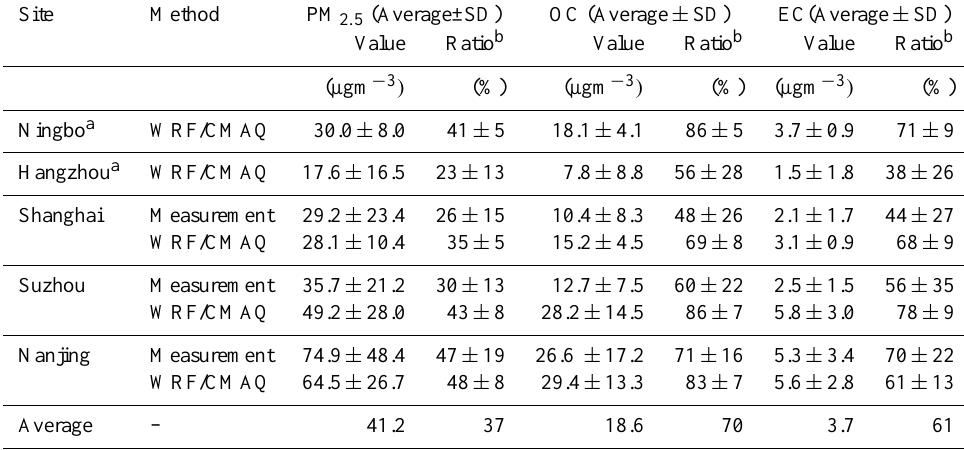
Table 3. Contribution of biomass burning to mass concentrations of PM 2 . 5 , OC and